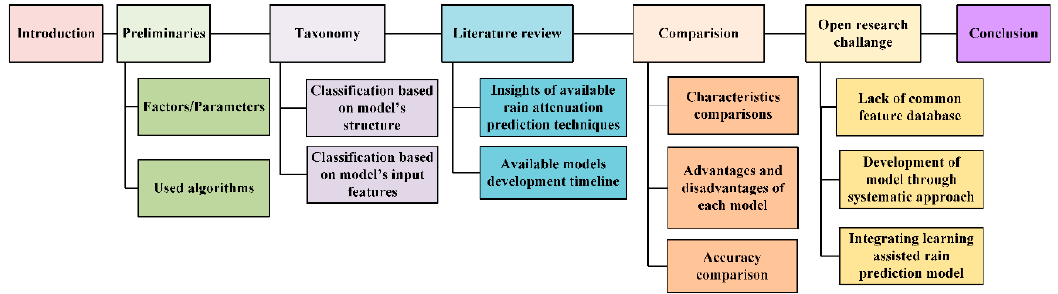
Figure 1. The visual orientation of the paper.